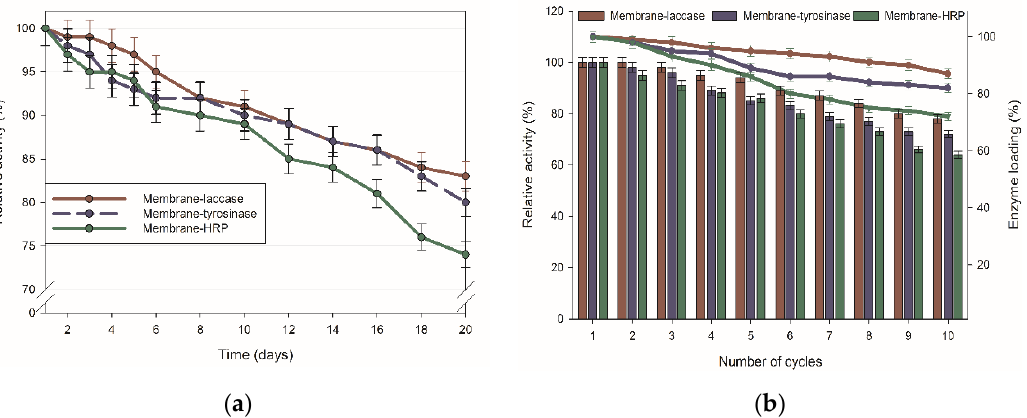
Figure 3. ( a ) Storage stability as well as ( b ) reusability (bars) and enzyme loading (points) over repeated use of the produced biocatalytic membranes. All values are presented with a mean value of 3 experiments ± standard deviation.